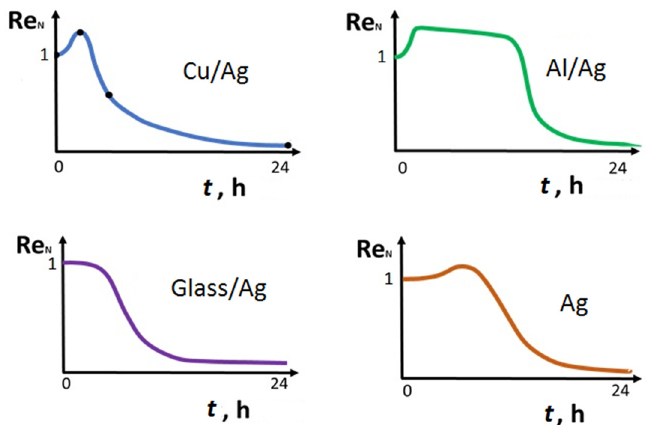
Figure 6. Normalized “real part” amplitude dependence on the cure time for 4 types of coatings at a frequency of 10 MHz.